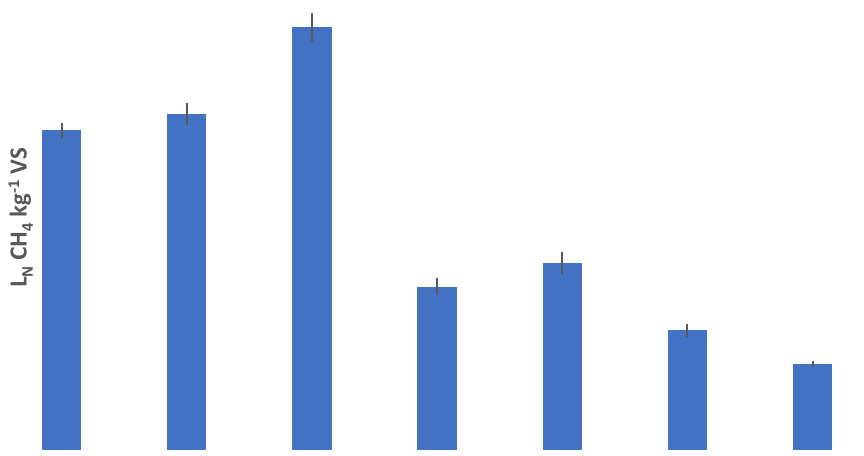
Figure 1. Total specific methane production of by-products from the alcoholic beverage production in L N CH 4 kg −1 vs. from the BMP tests (SD for each substrate: PA, 13; T, 19; GSW, 25; GSB, 15; BSG, 19; GM, 11; EGM, 5).